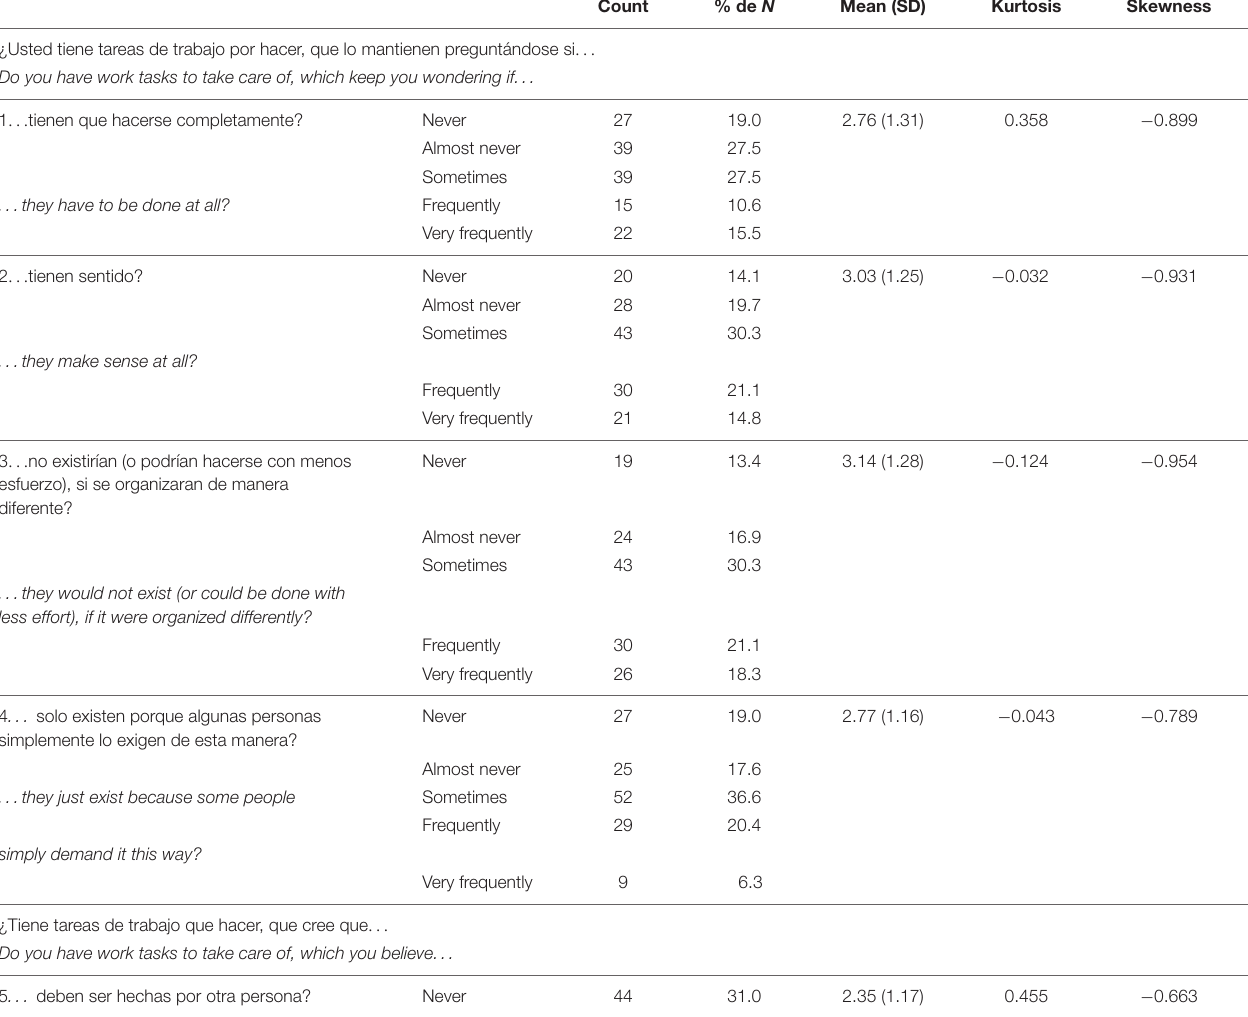
TABLE 2 | Descriptive statistics of the items of the BITS.